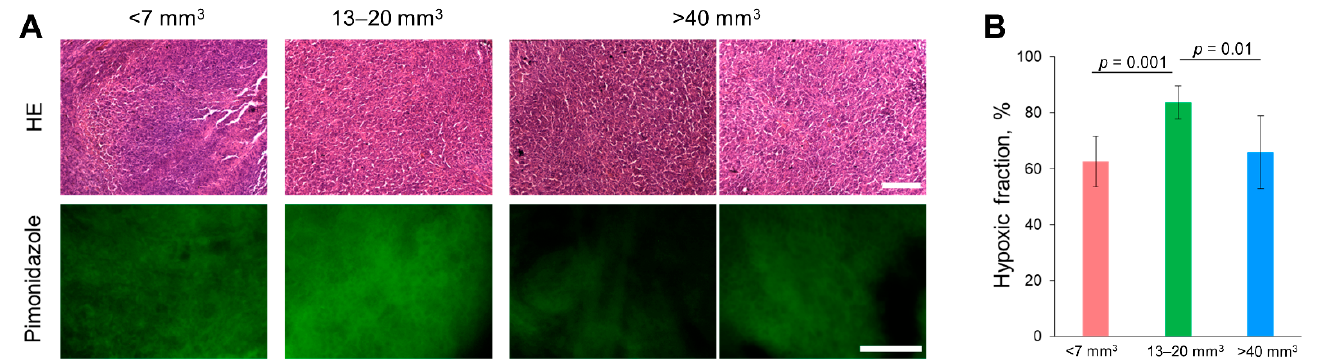
Figure 11. Histopathology and immunohistochemistry of CT26 tumors. ( А ) Upper row: representative histological slices of tumors, hematoxylin/eosin (HE) staining, initial magnification ×10. Scale bar = 270 µm. Bottom row: Immunohistochemical staining for hypoxia with pimonidazole. Scale bar = 20 µm. Initial magnification x10. ( B ) Quantification of hypoxic fraction. Mean ± SD.